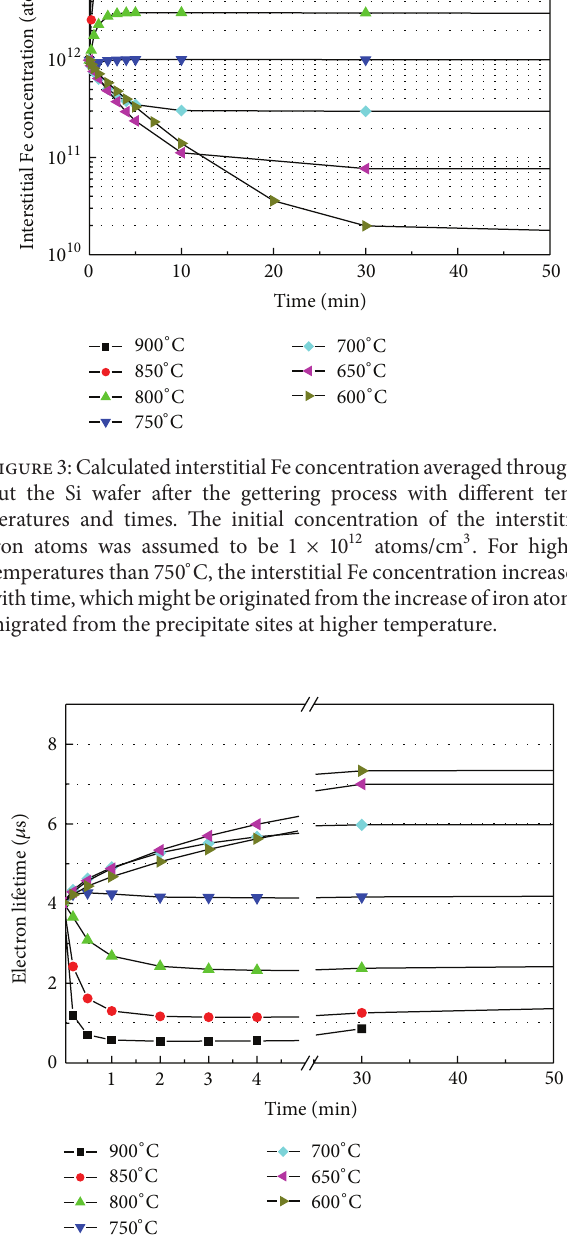
Figure4:Variationoftheaveragedelectronlifetimecalculatedfrom the distributions of iron atoms using I2E simulator. It was strongly dependent on the distribution of the interstitial Fe